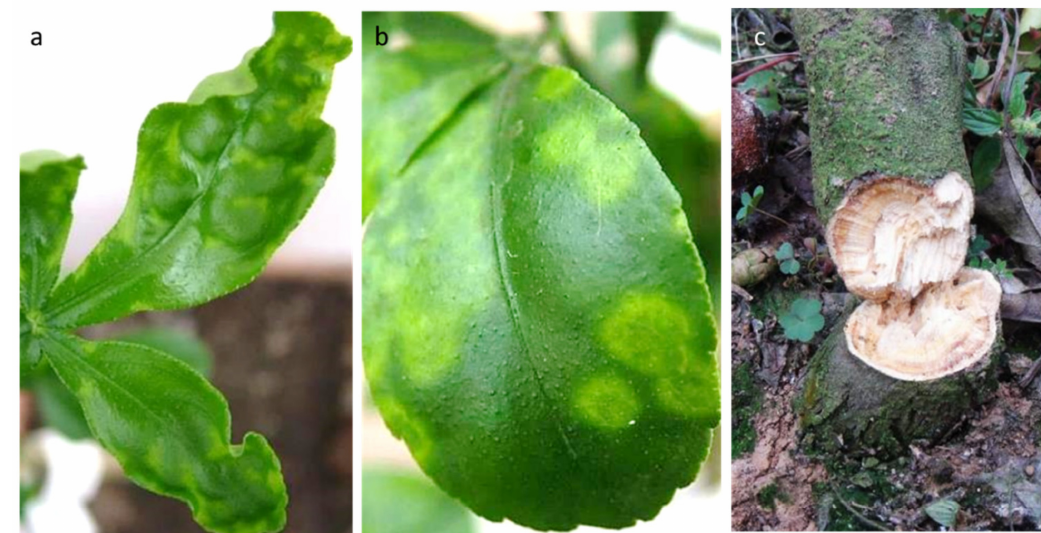
Figure 4. Mottling and tattered margins of a young leaf of Troyer citrange seedling inoculated with citrus tatter leaf virus ( a ), strong blotching of a mature leaf of the same seedling ( b ) and browning and bud-union collapse of a tree grafted on trifoliate orange ( c